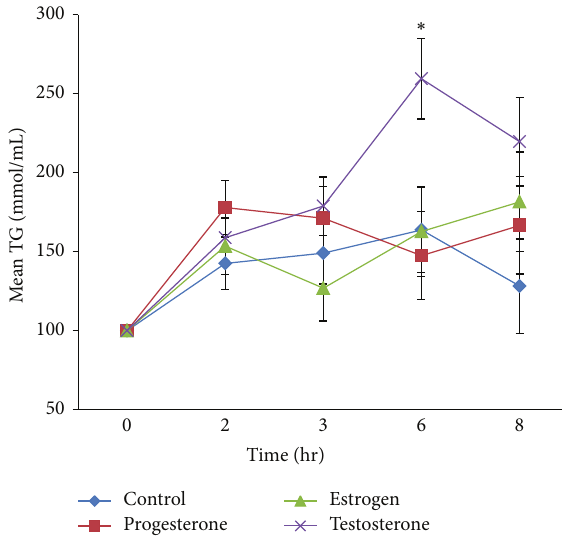
Figure 2: Changes in plasma triglyceride (TG) concentrations for different hormone treated groups and control group ( 𝑛 = 6 ). Results at each time point during postprandial period are expressed as means ± SEM (mmol/L) of difference in TG levels from basal (by subtracting basal values) from each time point and percentage increase was calculated. Two-way RM-ANCOVA adjusting for weight as a covariate demonstrated a significant interaction between hormonetreatmentandtime(hormonetreatment × time); 𝐹 = 2.31 , 𝑃 = 0.015 , and partial eta squared = 0.28. Significant changes were set at ∗ 𝑃 < 0.05